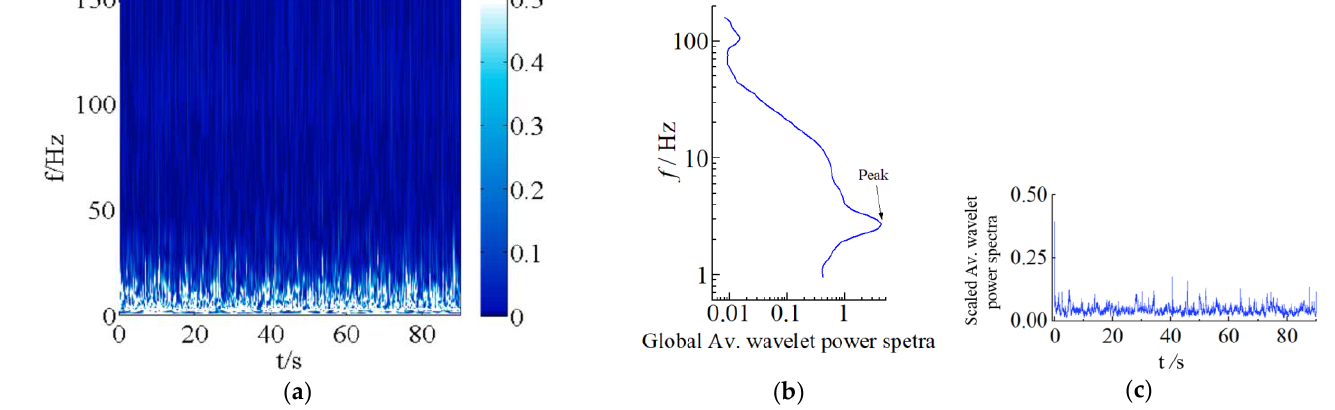
Figure 8. Wavelet power spectra over time-frequency (point 23 on layer H with a wind direction of 90 ◦ ). ( a ) Wavelet transform of point 23; ( b ) global averaged spectrum of ( a ) in frequency domain; ( c ) scaled averaged spectrum of ( a ) in time domain.